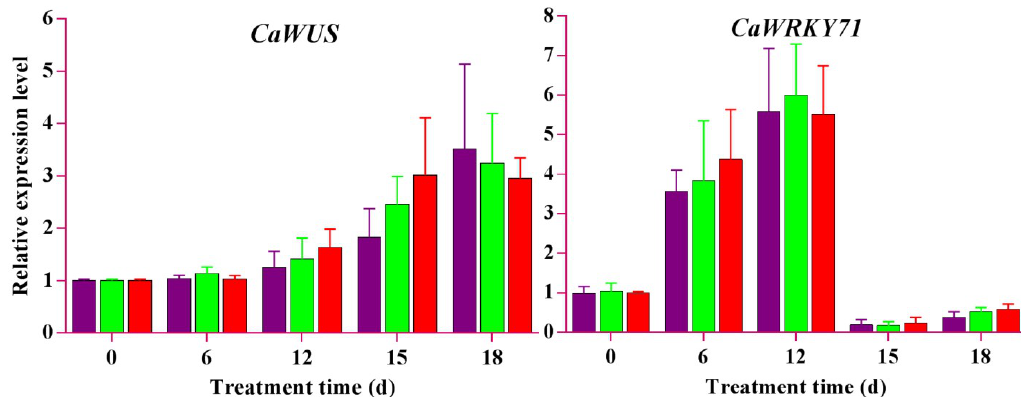
Figure 8. The relative expression levels of 10 candidate DEGs were measured during the lateral bud elongation process in C. appendiculata by qRT-PCR. Auxin synthesis and metabolic genes: CaYUCCA and CaDAO ; cytokinin synthesis and metabolic genes: CaCYP735A , CaIPT , and CaCKX ; strigolactone synthesis genes: CaCCD7 and CaCCD8 ; and transcription factors: CaBRC1 , CaWUS , and CaWRKY71 . Values are means ± SD, n = 3. Error bars indicate the standard deviations obtained from three biological replicates.